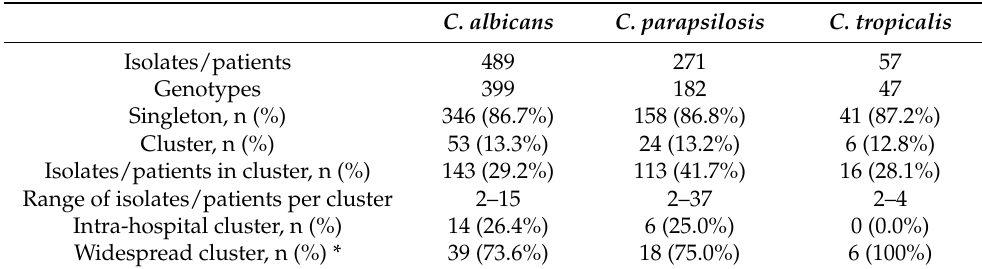
Table 2. Number of isolates, patients, and genotypes found in blood per species, and genotype